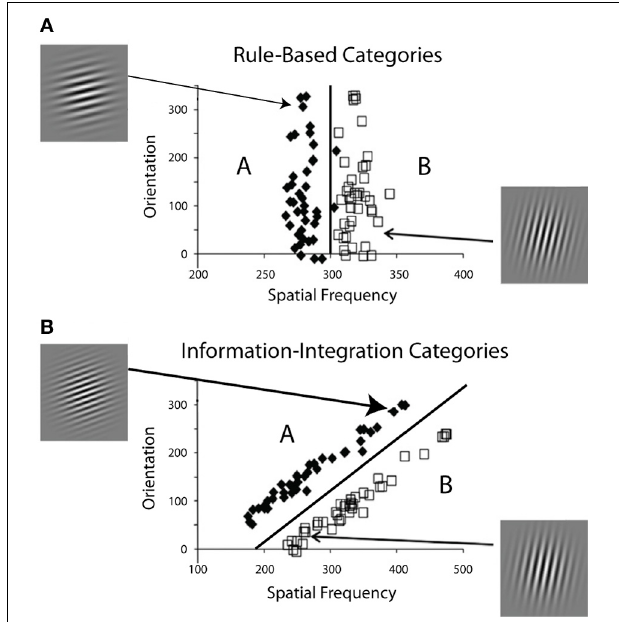
FIGURE 1 | Two category structures used in the experiments, along with sample stimuli from each category. (A) A one-dimensional rule-based structure, and (B) a two-dimensional information-integration